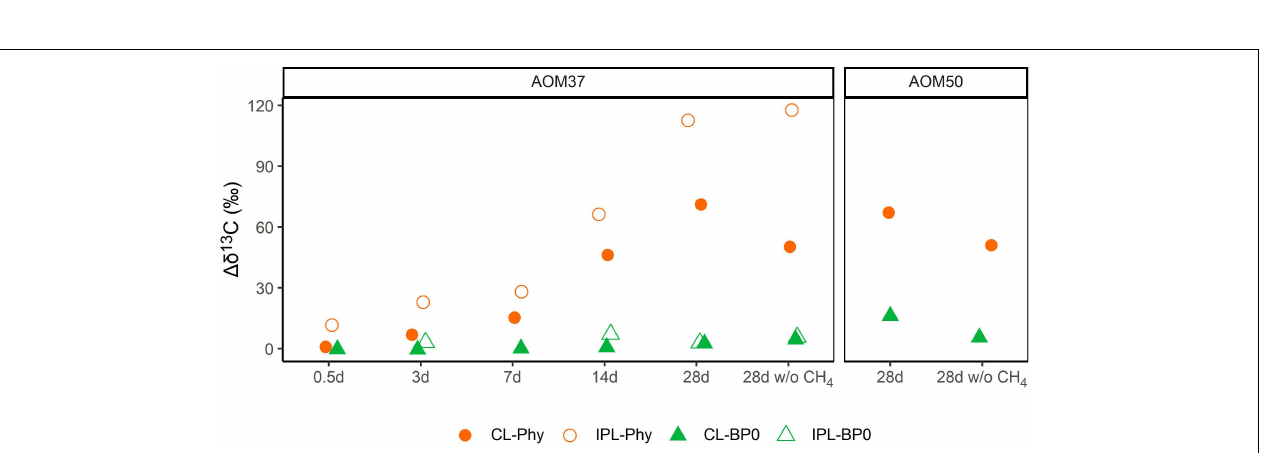
FIGURE 4 | Pattern of 13 C-incorporation into bacterial FAs in the AOM37 and AOM50 cultures during 13 C-leu incubation with and without (w/o) CH 4 after 28 days (experiments 1 and 3, respectively).